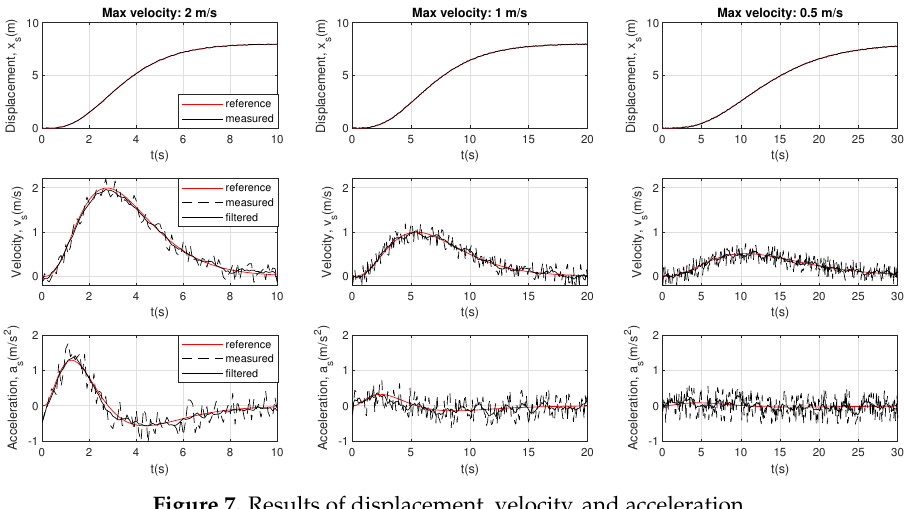
Figure 7. Results of displacement, velocity, and